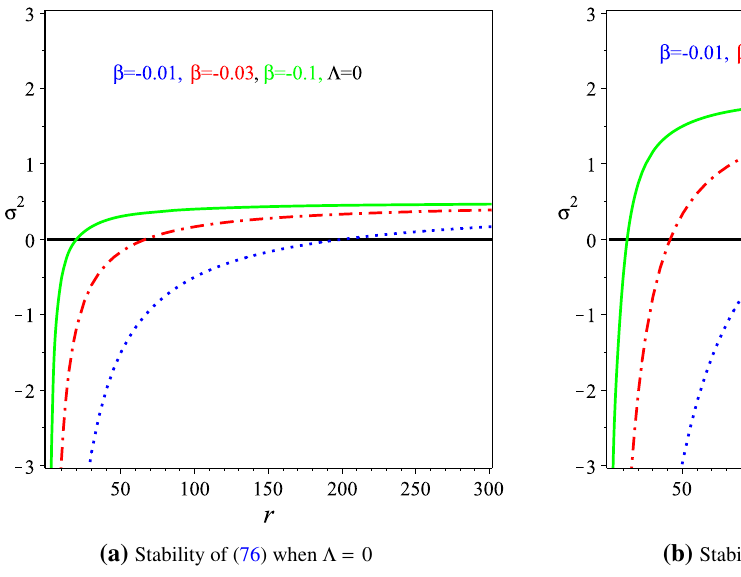
( a ) Stability of (76) when Λ = 0 (b) Stability of (76) when Λ ≠ 0 Fig. 13 Schematic plot of Eq. (76), namely σ 2 versus the coordinate